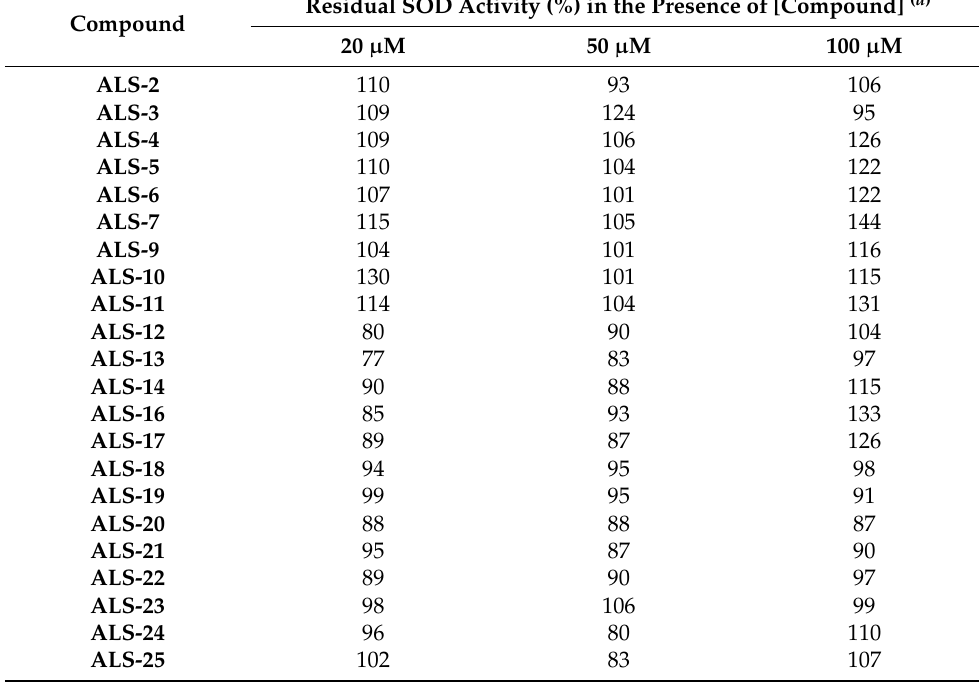
Table 1. Residual activity of Sm SOD in the presence of compounds selected by virtual screening.